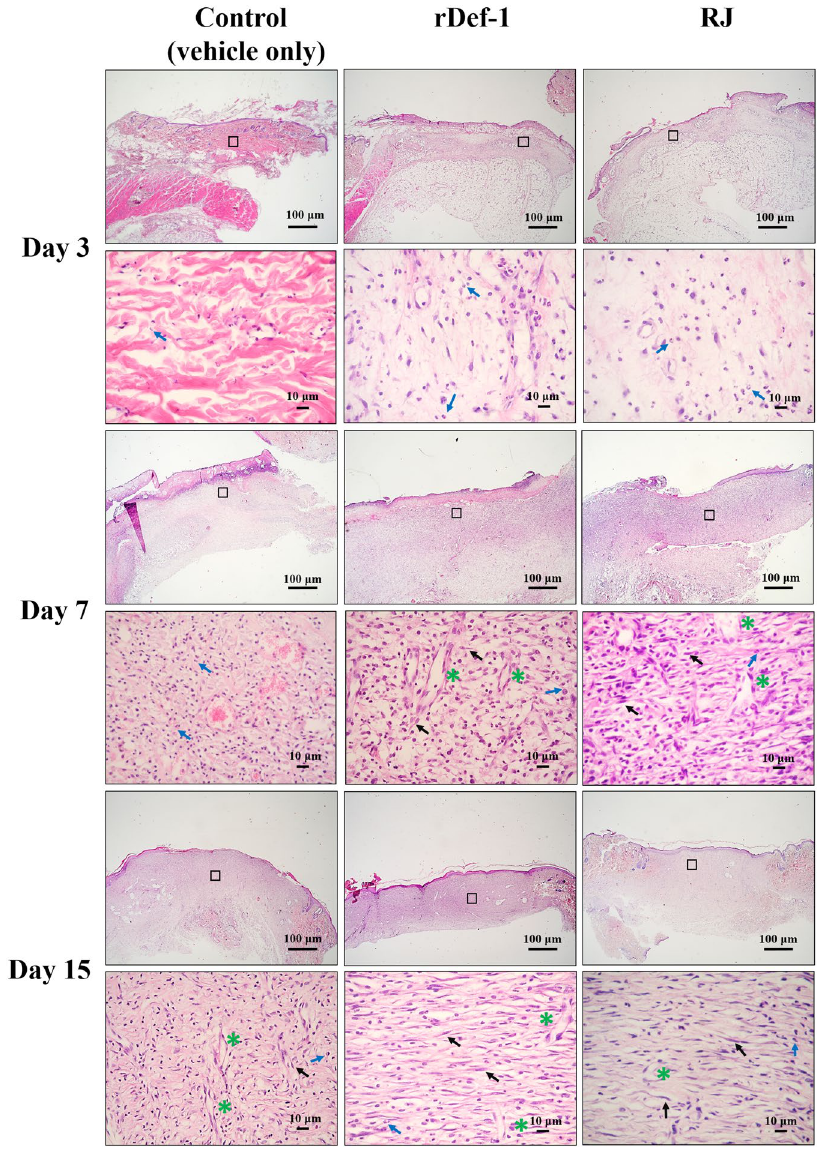
Figure 7. Representative pictures of haematoxylin and eosin-stained sections of wounds (n = 4 per time points) at days 3, 7 and 15 post-wounding exhibiting differences in epithelisation between vehicle (carboxymethyl cellulose)-treated and rDef-1- and RJ-treated wounds. Blue arrows indicate inflammatory cells. Black arrows indicate fibroblasts. Green asterisks indicate new blood vessels. Scale bar = 100 and 10 μ